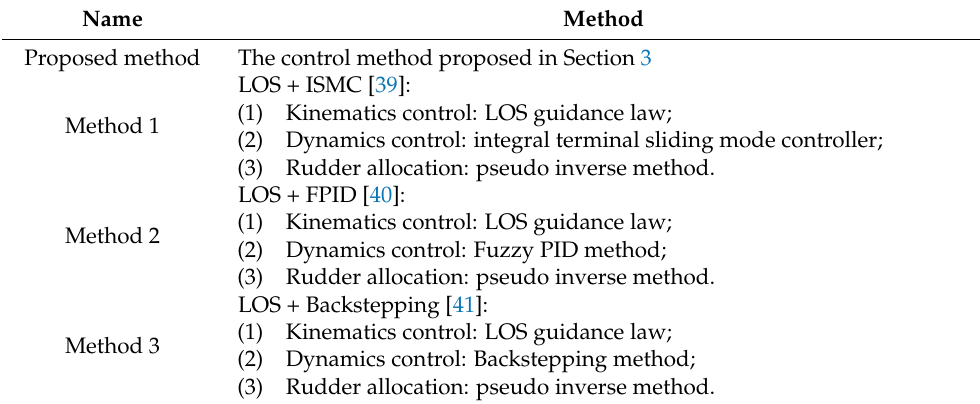
Table 7. Different control methods utilized for comparison in Case 2.